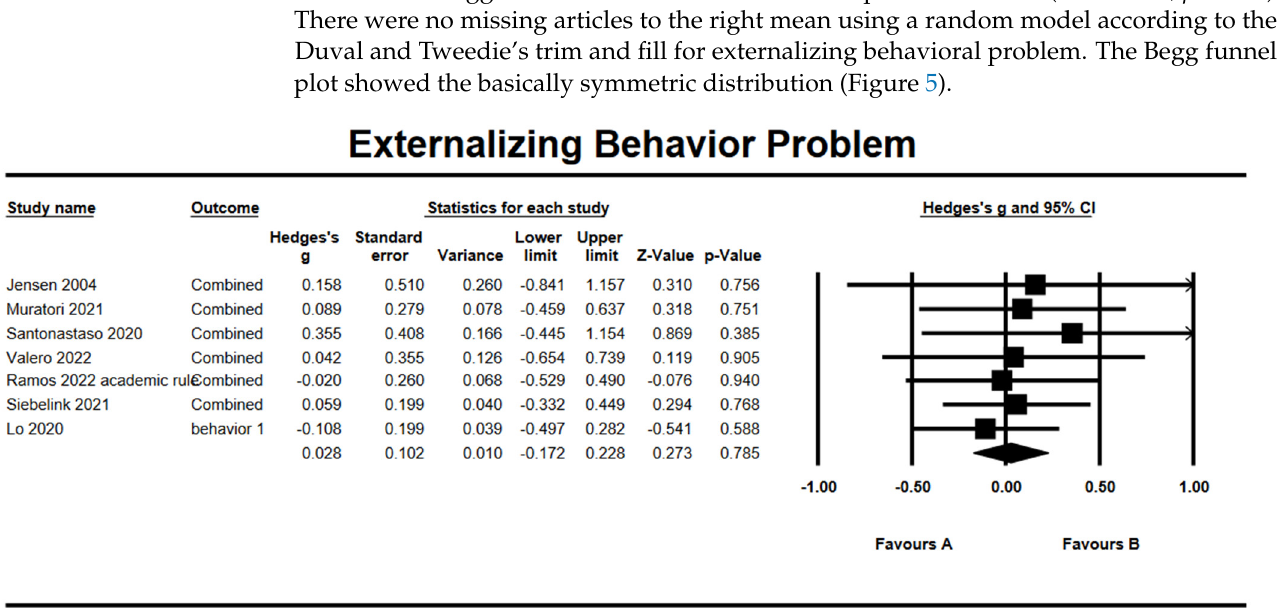
Figure 4. Forest plots of effect size for externalizing behavioral problem [31–33,35,36,38,39].